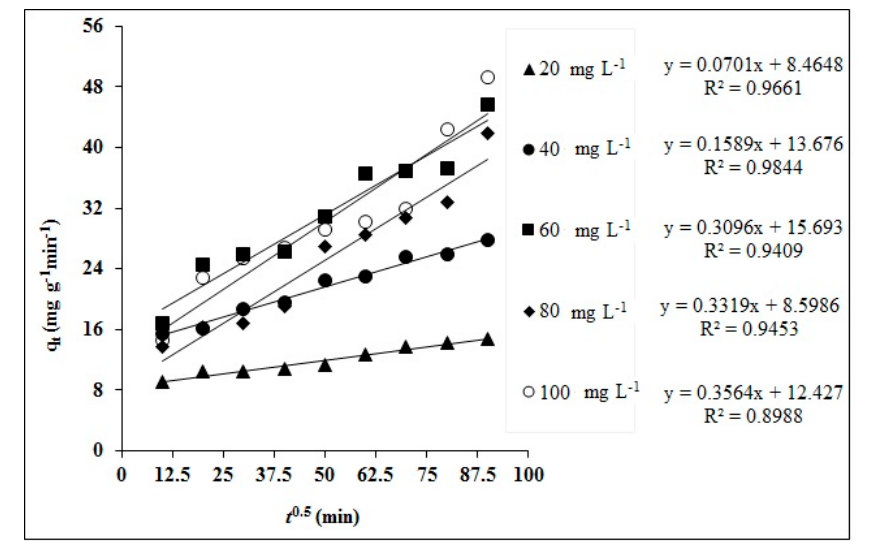
Figure 11. Intraparticle diffusion linear kinetic fitness plot for RO16 adsorption onto MA-AC400.